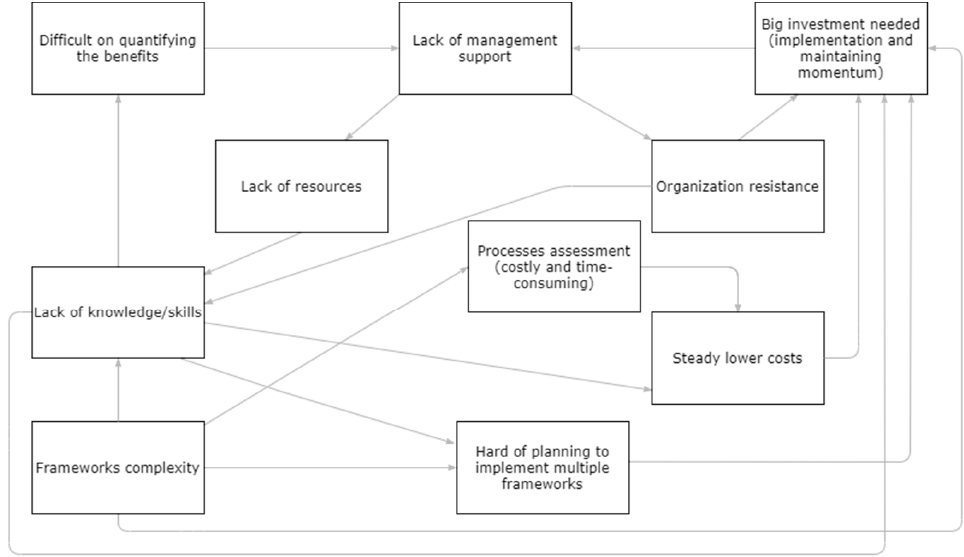
Figure 8. ITSM Challenges Conceptual Model.